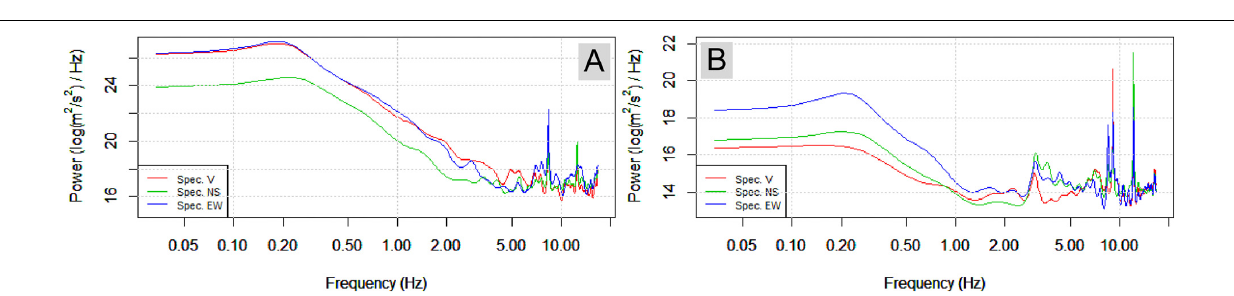
FIGURE 3 | (A) The spectrum of the vertical and horizontal components at Station MM029. (B) The spectrum of the vertical and horizontal components at Station MM099. The red line represents the vertical component spectrum, while the green and blue lines represent the horizontal NS and EW component spectrums,